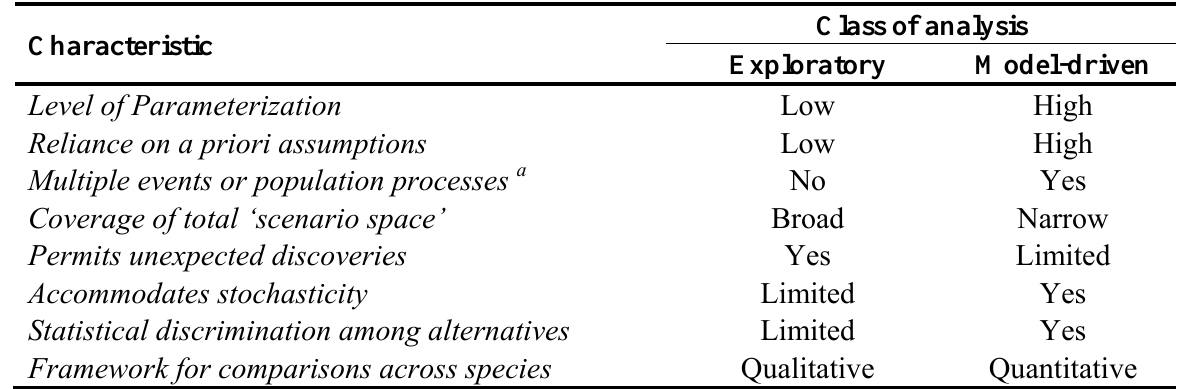
Table 1. Characteristics of two major classes of phylogeographic analysis. Although ‘exploratory’ and ‘model-driven’ analyses are not mutually exclusive, the dichotomy can serve as a conceptual